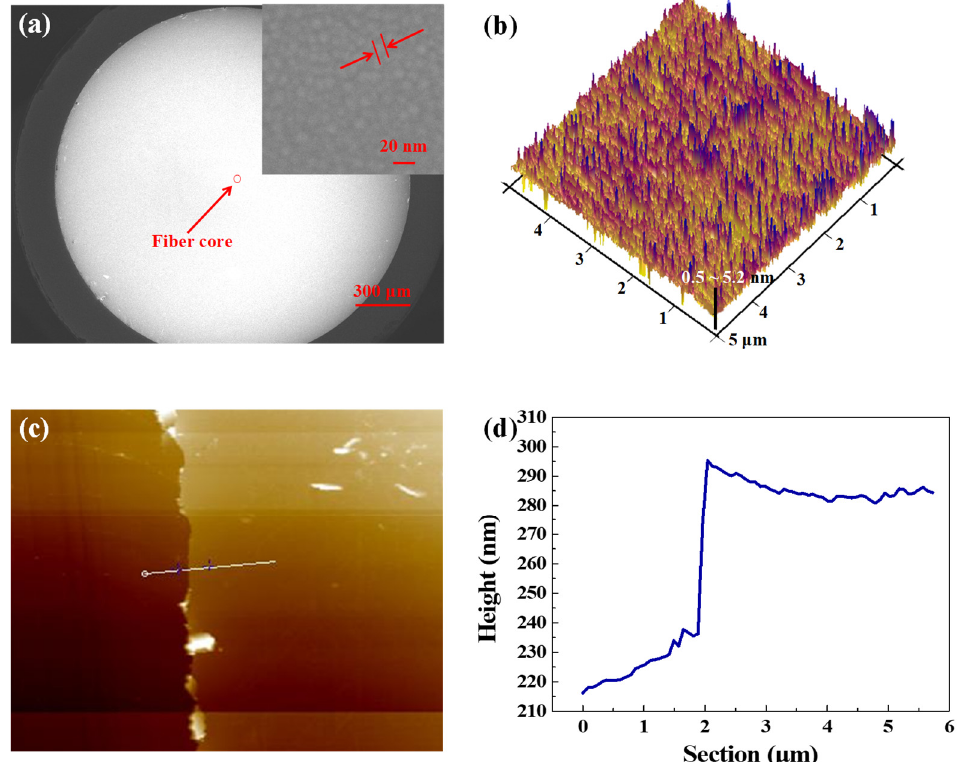
Figure 1. ( a ) Scanning electron microscope (SEM) image of the fiber connector after depositing indium tin oxide (ITO) film (inset, the SEM investigated at the center region), ( b ) the 3D atomic force microscope (AFM) image of the ITO film on SiO 2 substrate, ( c ) the AFM image of the ITO film, and ( d ) the height measurement of the selected area in ( c ).